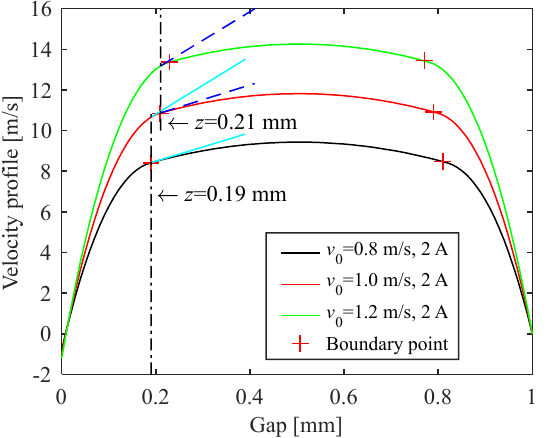
Figure 19. Velocity profiles with respect to various volume flow rate in the activated region.